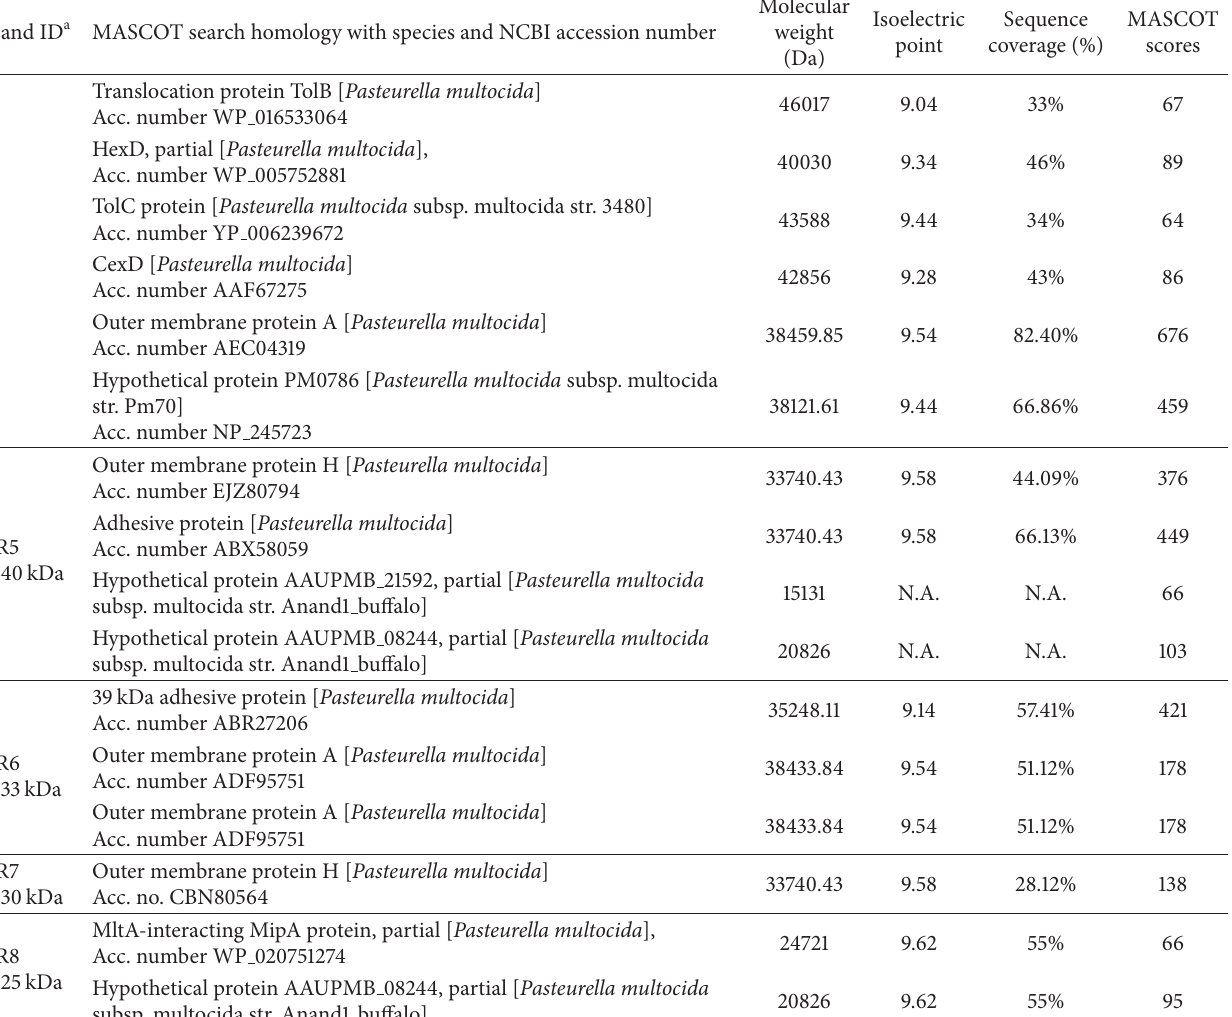
a Bands correspond to Figure 1.